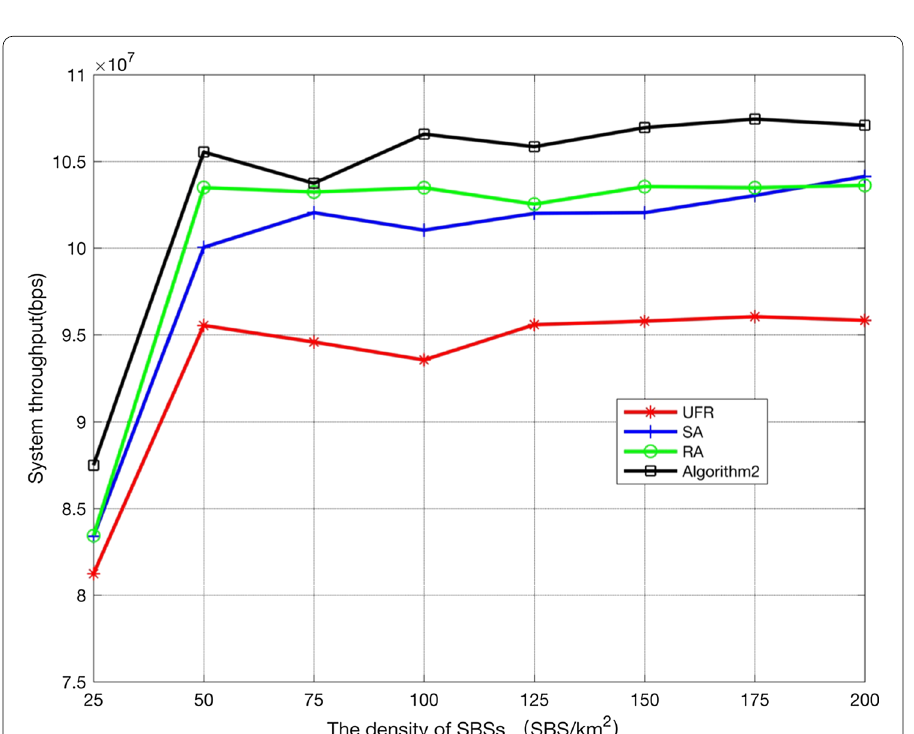
Fig. 12 The system throughput versus the density of